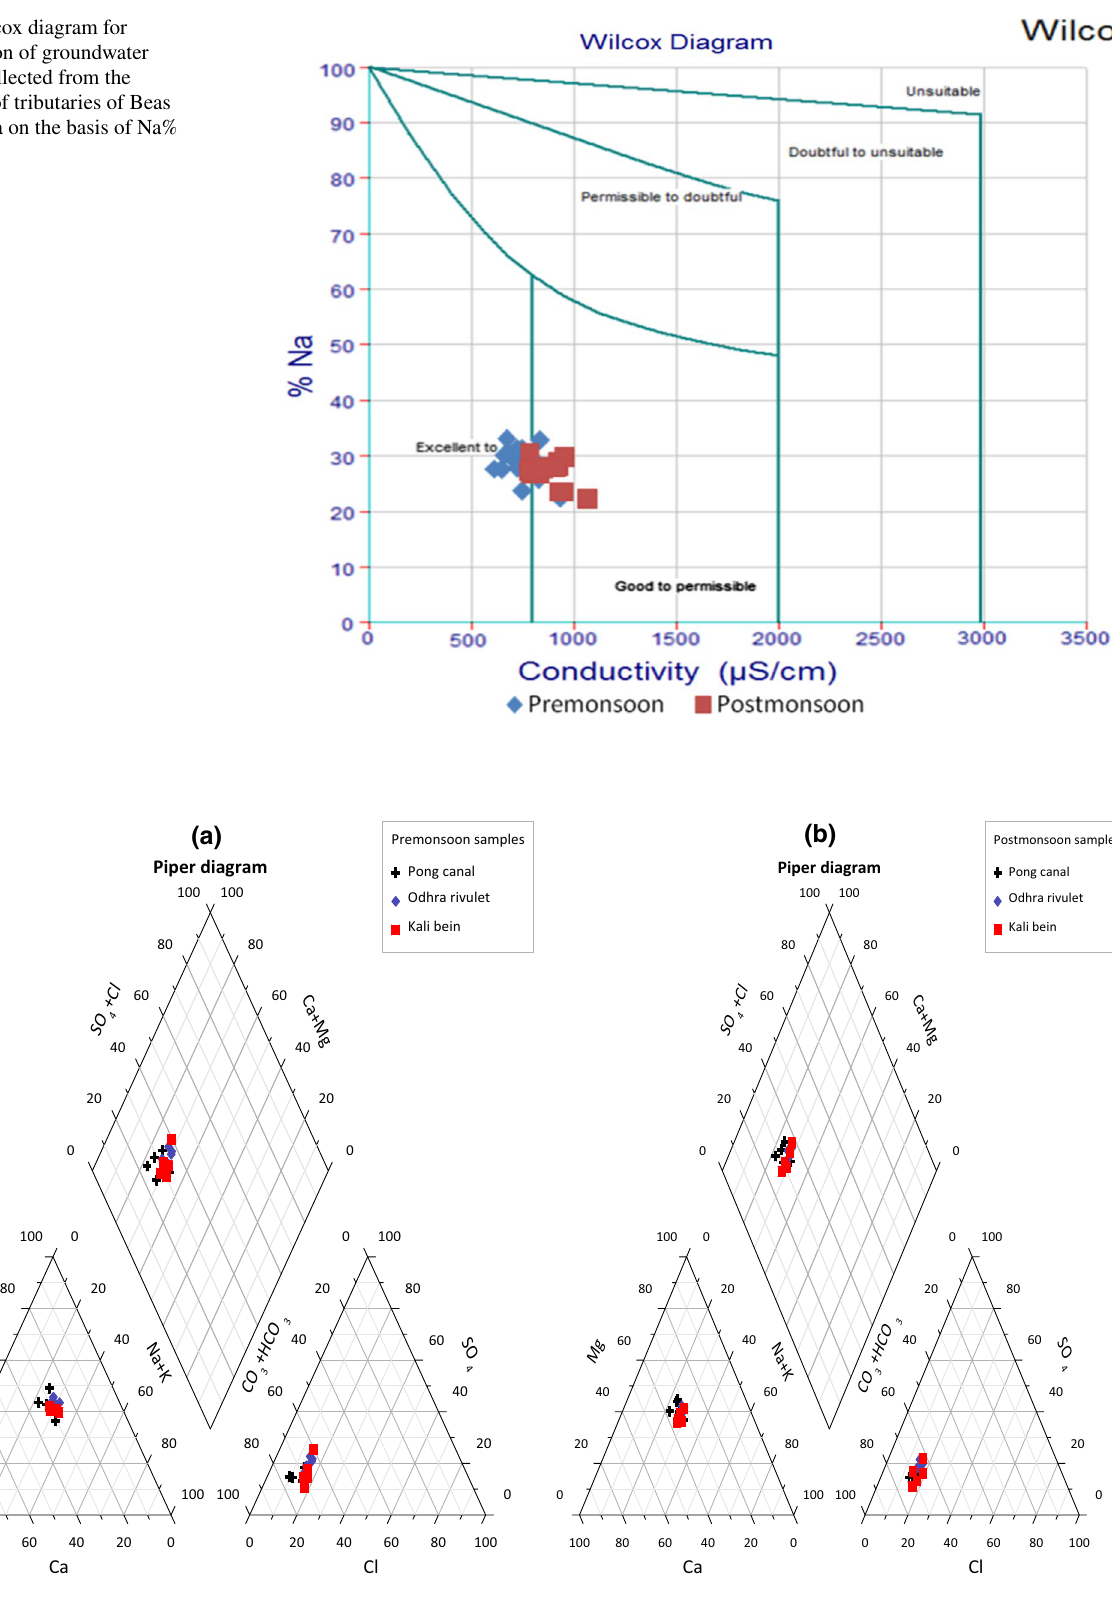
Fig. 4 a Geochemical classification of groundwater samples collected during the pre-monsoon season using Piper diagram b Geochemical clas- sification of groundwater samples collected during post-monsoon season using Piper